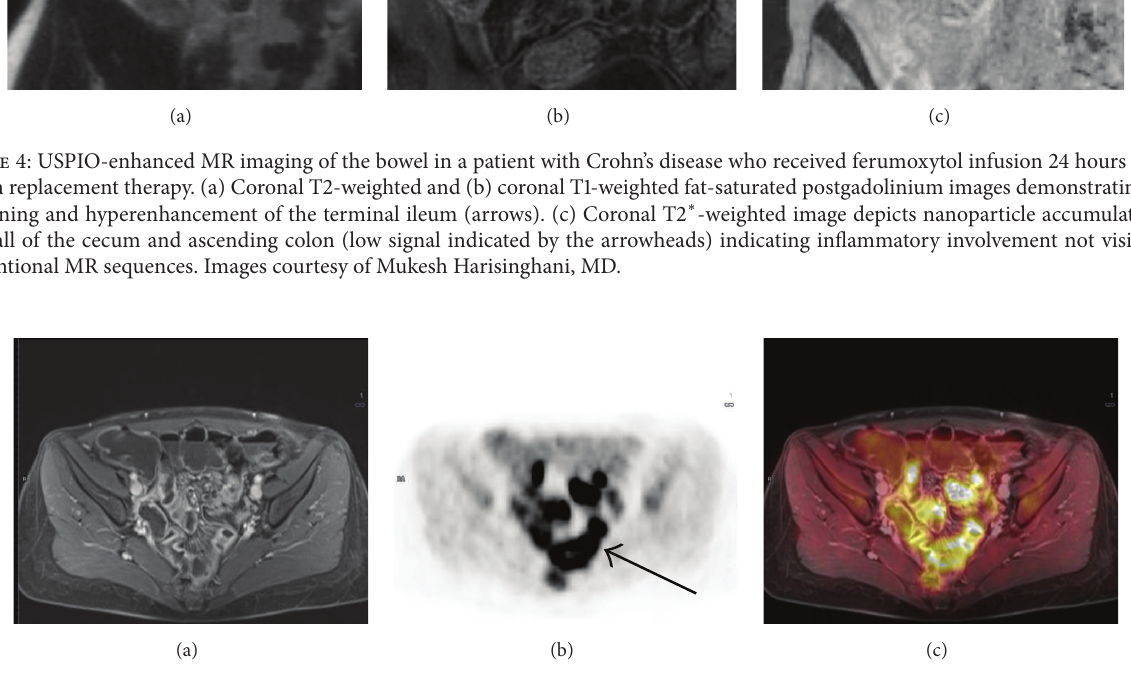
Figure 5: Simultaneous 18 F-FDG PET/MR in a patient with known Crohn’s disease. (a) Axial T1-weighted fat-saturated postcontrast images with mucosal hyperenhancement of several loops of small bowel in the lower abdomen consistent with active inflammation. (b) Attenuation- corrected PET images demonstrate intense 18 F-FDG uptake in these bowel loops. (c) Fusion overlay images demonstrate localization of 18 F-FDG avidity to the enhancing small bowel loops. Images courtesy of Onofrio Catalano,